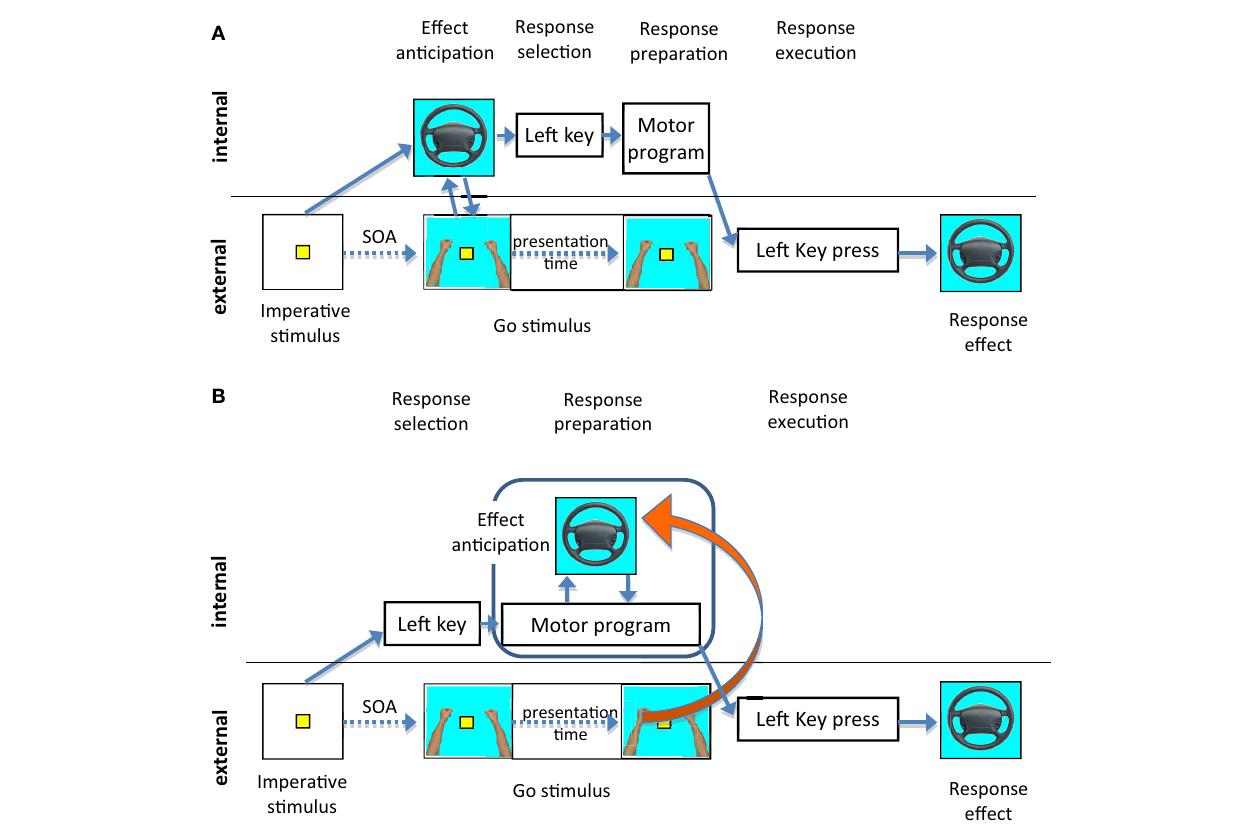
facilitate the selection of the response, provided the Go stimulus was presented before the completion of the response selection. (B) The response is selected depending on the imperative stimulus. After response selection the effect of the response is anticipated to enable the monitoring of the response and error detection.The anticipation is supported by a compatible Go stimulus throughout response